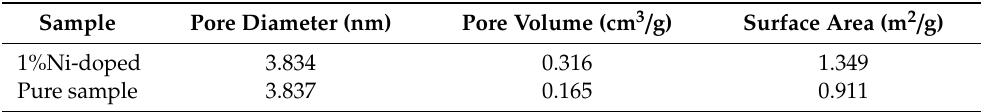
Table 2. Pore structures of